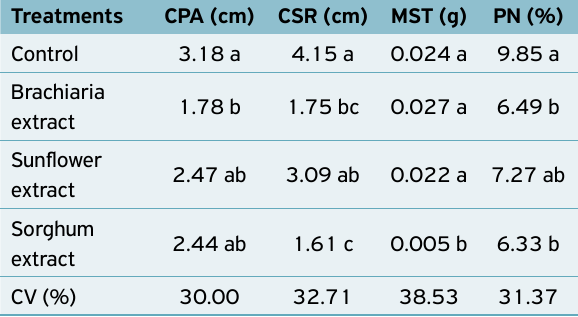
Table 1. Analysis of variance summary for variables germination percentage, average germination time, germination speed index, shoot length, root system length, total dry matter and percentage of normal seedlings of Bidens pilosa L. submitted to treatments with extracts, Cruz das Almas, BA, 2013.